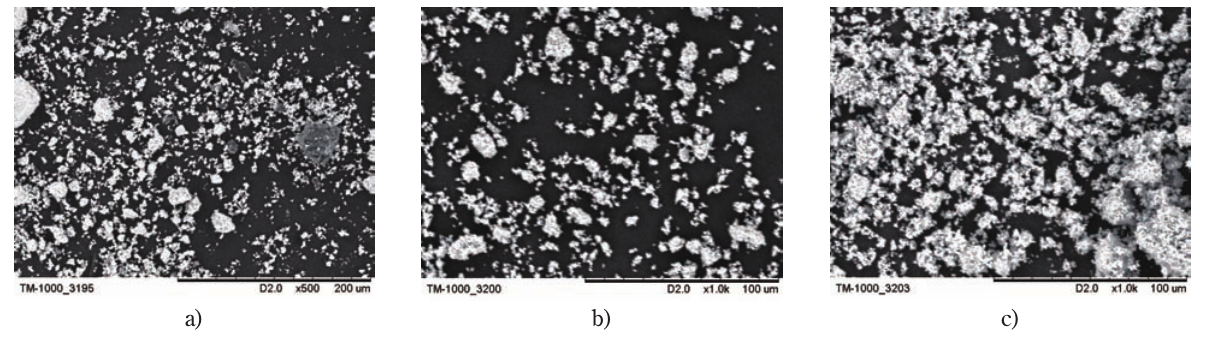
Fig. 3 Electron microscopic images of the samples containing 0.2 CuO: a) − Initial powdered mixture; visible are the particles possessing the anisotropic shape. Magnification - 500 b) − Mechanical activation for 10 min; the formation of smaller particles. Magnification - 1000 c) − Mechanical activation for 30 min; the formation of rather large aggregates. Magnification